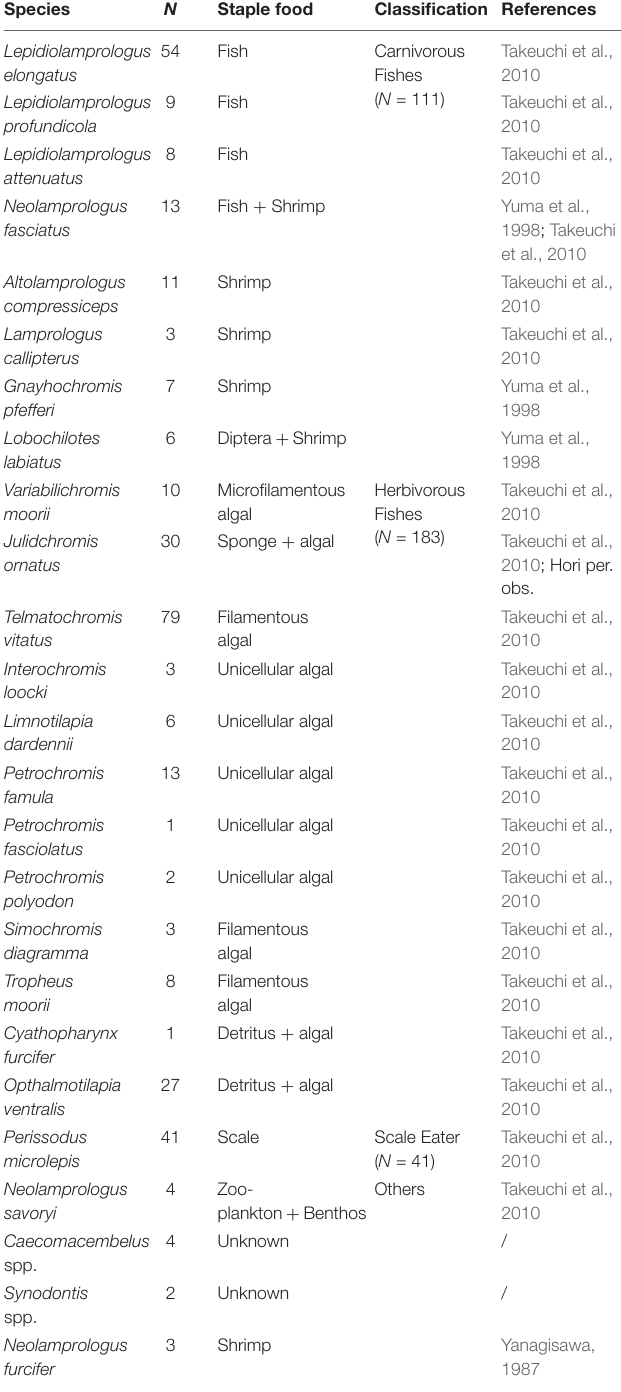
TABLE 1 | Classification of intruder fishes based on habitat and feeding